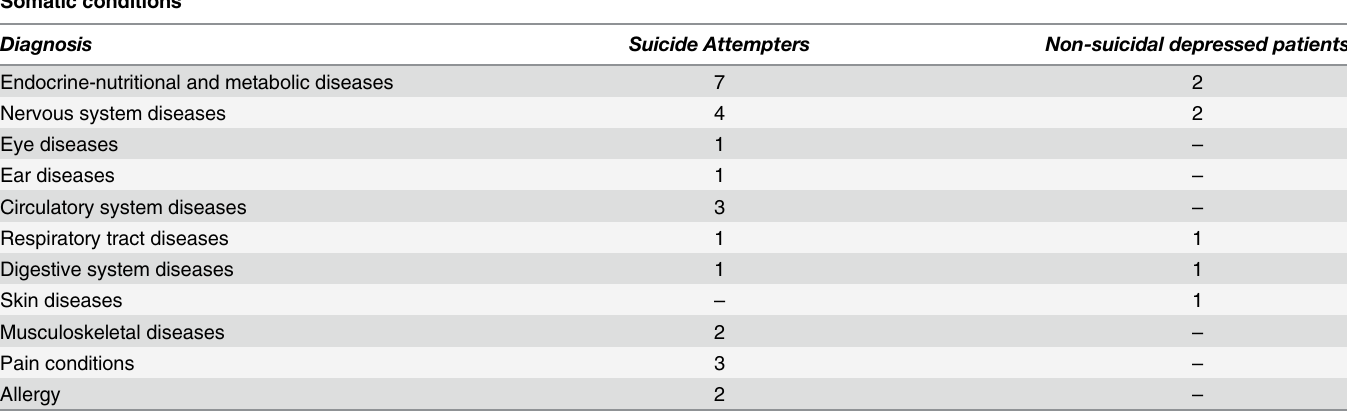
ence between the areas below the curves of suPAR and CRP equals p = 0.0053. Table 2. Somatic diagnoses of the suicide attempters and non-suicidal depressed patients. Somatic